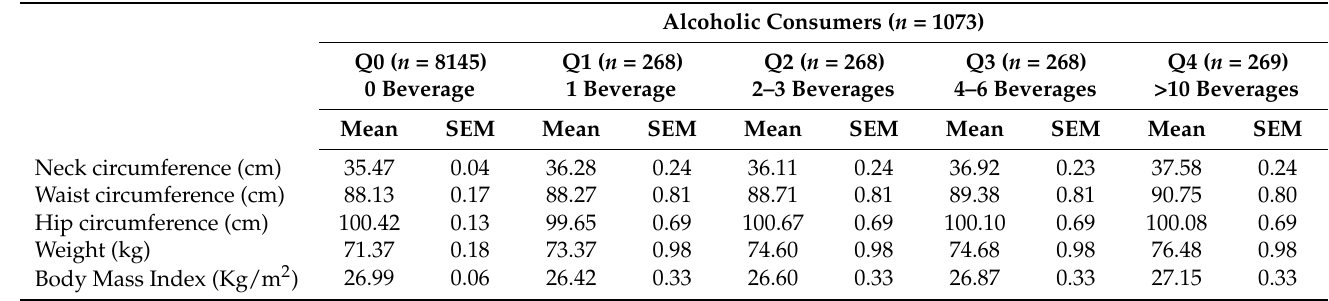
Table 7. Anthropometric measurements according to alcohol consumption quartiles.